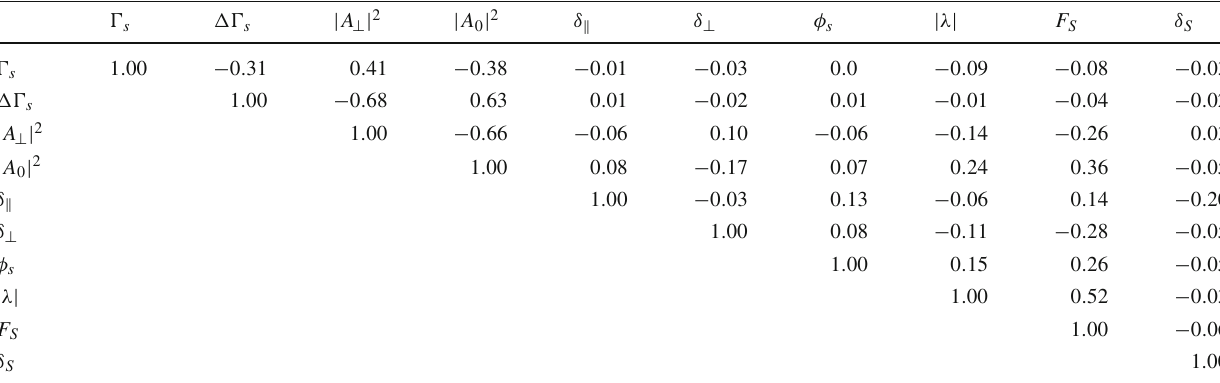
Table 5 Correlation matrix of statistical